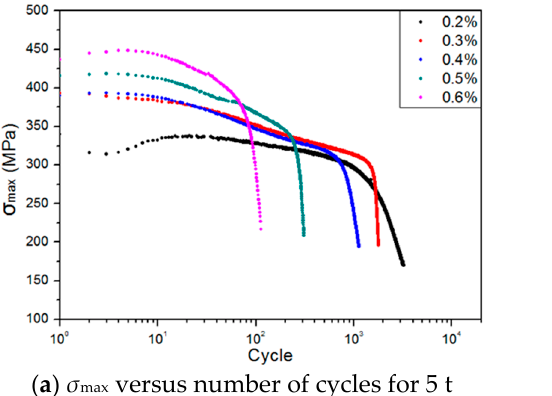
Figure 5. σ max versus number of cycles under R = 0.